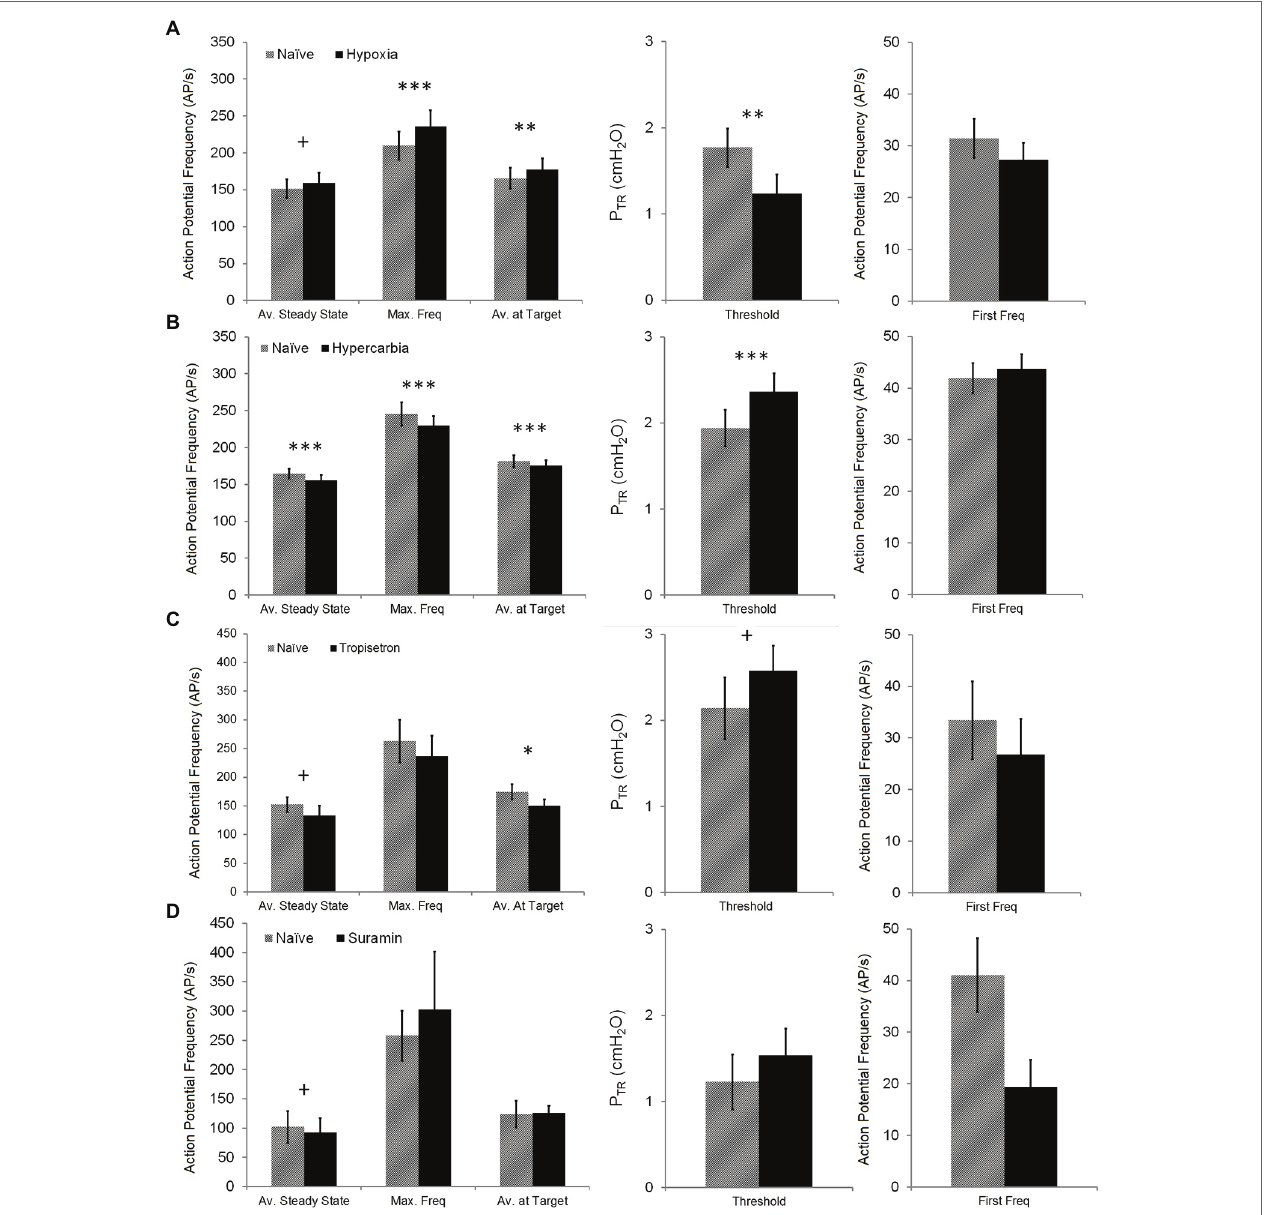
FIGURE 5 | Impact of chemosensory or pharmacologic challenges on SAR activation and steady state SAR activity. The impact of hypoxia (top row— A ), hypercarbia (second row— B ), Tropisetron (third row— C ), and Suramin (bottom row— D ) on Av. Steady State (mean AP f over 1 s, measured 5 s after target P TR of 20 cmH 2 O was attained), Max. Freq (maximum single frequency), Av. at Target (mean AP f over 1 s measured when target P TR of 20 cmH 2 O was attained), Threshold (P TR pressure required to initiate SAR activation during slow inflation), and First Freq (instantaneous AP f at SAR activation onset) was assessed. Hypoxia had an opposite effect on Av. Steady State (increased) compared with hypercarbia, Tropisetron, and Suramin (decreased). Hypoxia also increased Max. Freq and Av. at Target, whereas these were decreased in hypercarbia (Av. at Target was also decreased in Tropisetron). Conversely, hypoxia decreased Threshold, while hypercarbia and Tropisetron increased Threshold. There was no impact of any intervention on first firing frequency. Difference between naïve and test conditions: + p < 0.05; * p < 0.01; ** p = 0.001; and *** p < 0.001. All data are mean ±